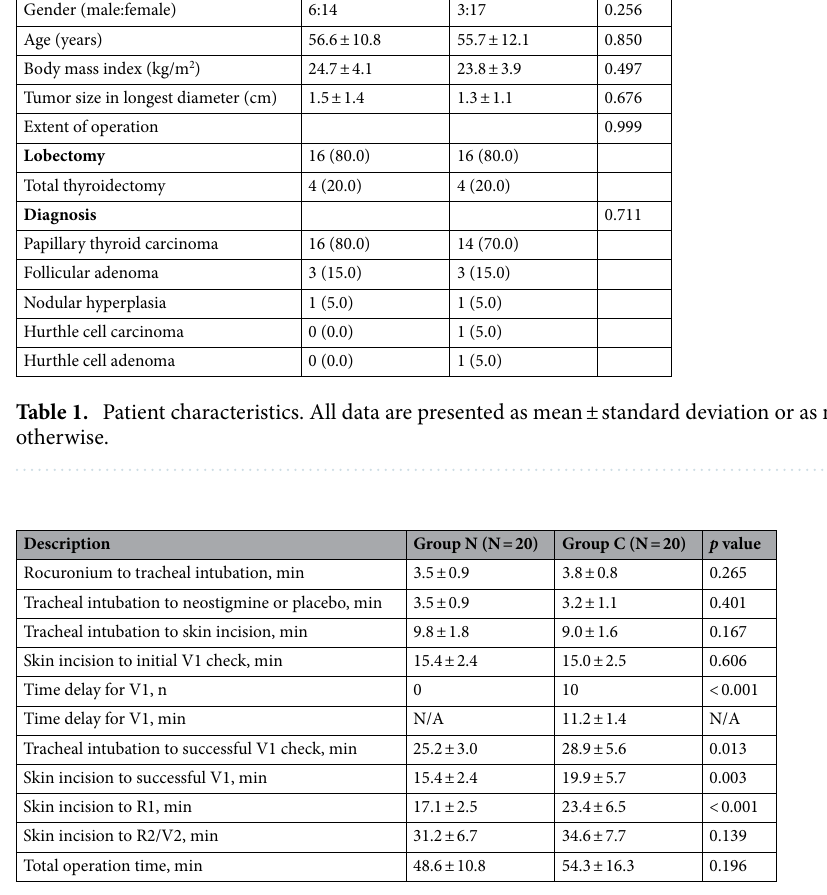
Table 2. Time measurements of anesthetic and operative procedures. All data are presented as mean ± standard deviation, unless stated otherwise. EBSLN external branch of the superior laryngeal nerve, V1 initial electromyography signal of the vagus nerve before surgical dissection, R1 initial electromyography signal of the recurrent laryngeal nerve upon its initial identification, R2 electromyography signal of the recurrent laryngeal nerve after thyroidectomy, V2 electromyography signal of the vagus nerve after thyroidectomy.